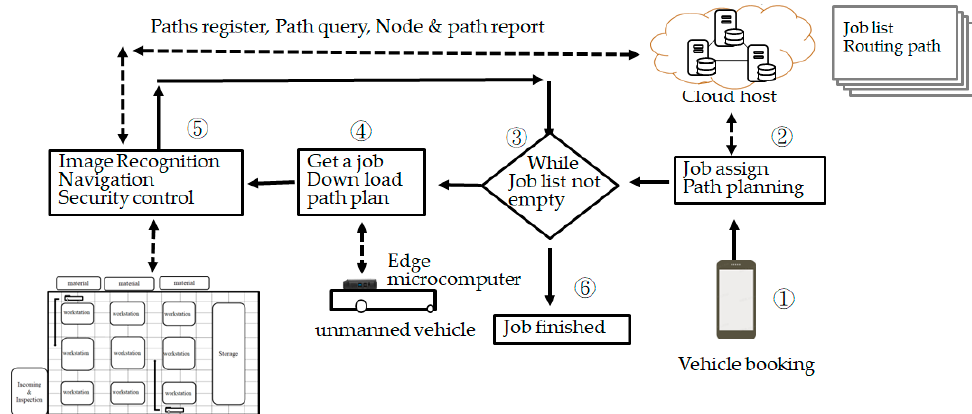
Figure 7. System